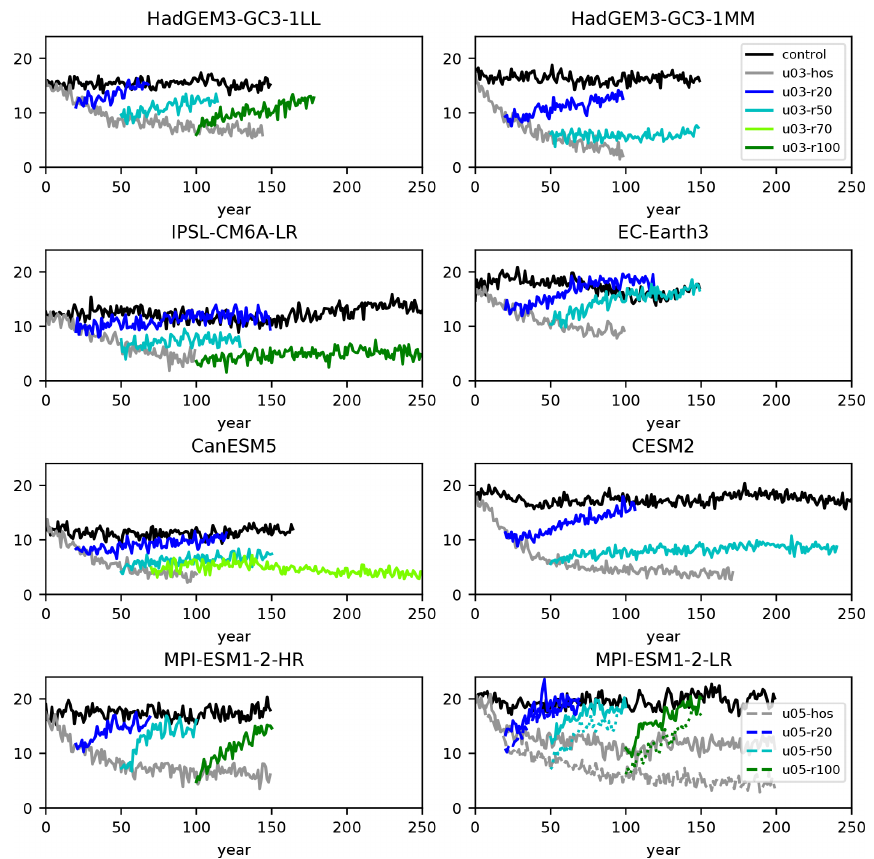
Figure 3. AMOC strength (maximum in depth at 26.5 ◦ N) for UH experiments. Each panel shows experiments conducted with different models. Experiments are the control (black), u03-hos (grey), u03-r20 (blue), u03-r50 (cyan), u03-r70 (light green), and u03-r100 (green). MPI-ESM1-2-LR also shows the same experiment with a stronger hosing rate of 0.5Sv (dashed